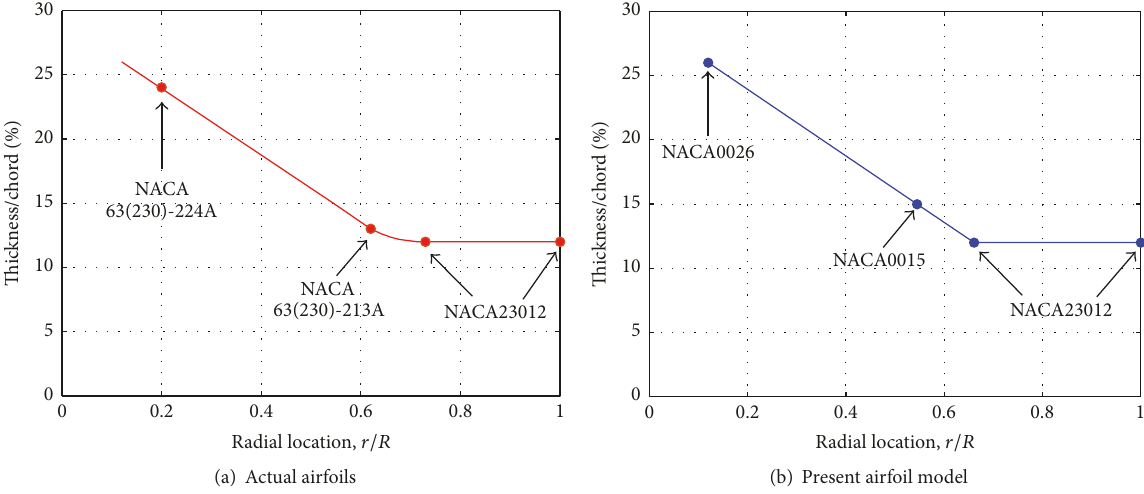
Figure 5: Blade thickness and airfoil distribution.